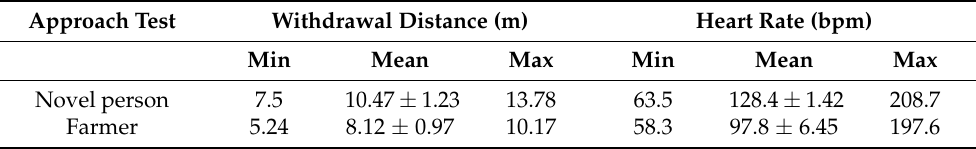
Table 3. Mean ± SD of avoidance distance and heart rate measured in 52 farms for ewes at lambing and